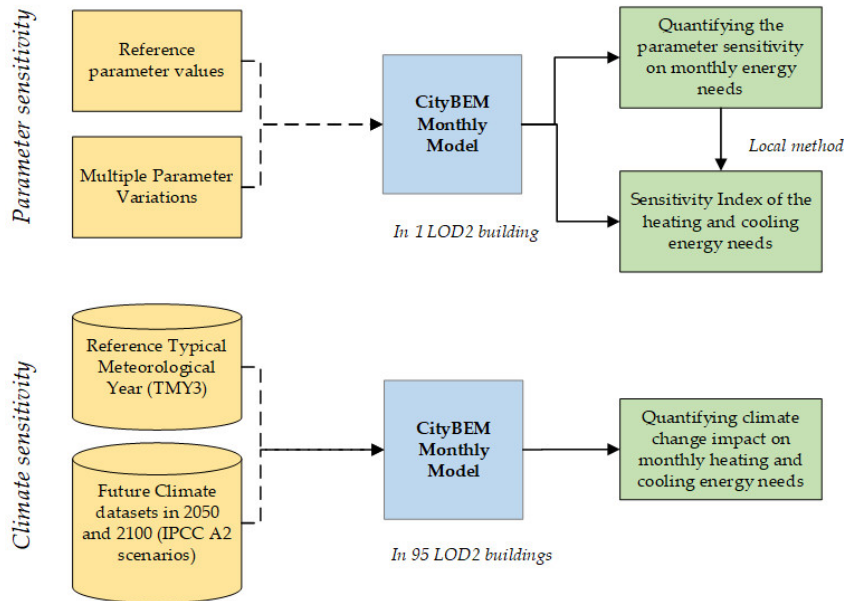
Figure 10. Sensitivity analyses approach for the CityBEM monthly model.